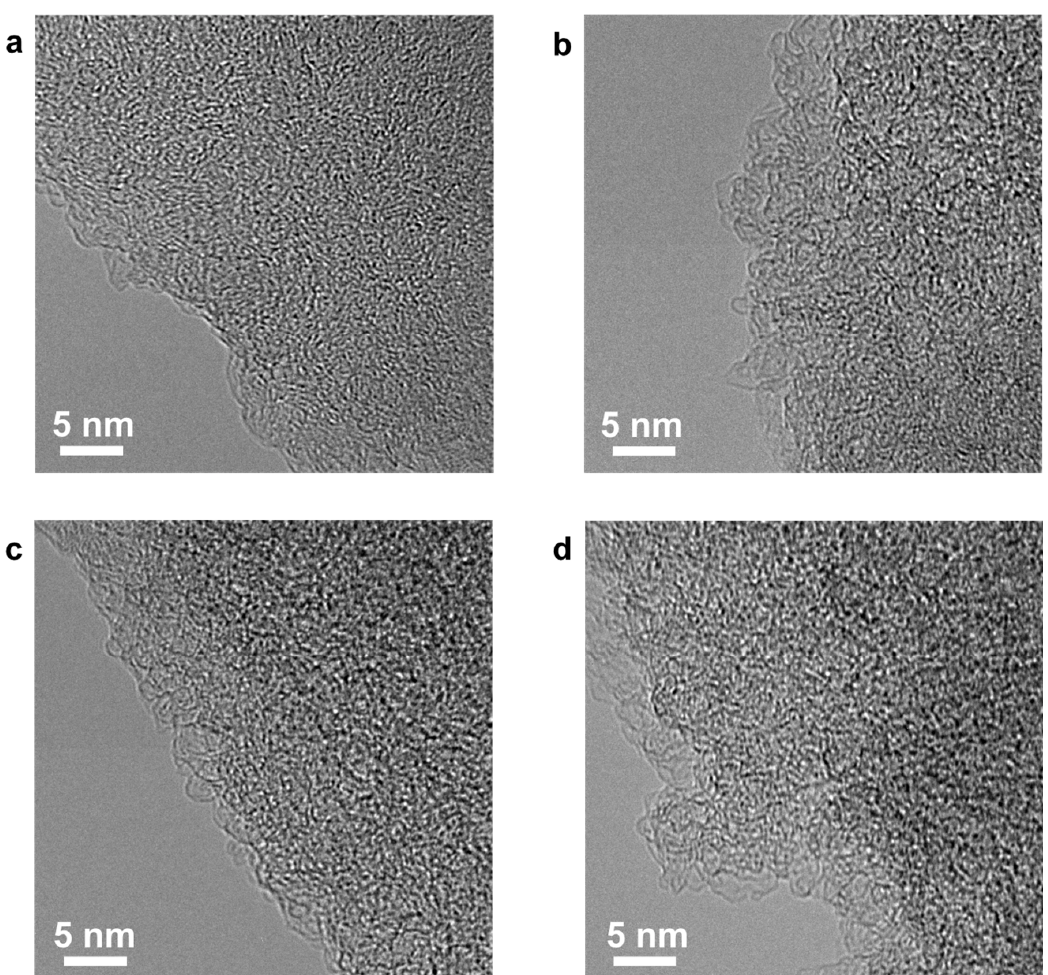
Figure 2. High-resolution FE-TEM images of ( a ) NE2-C-AEMs, ( b ) NE4-C-AEMs, ( c ) NE6-C-AEMs, and ( d ) NE8-C-AEMs.